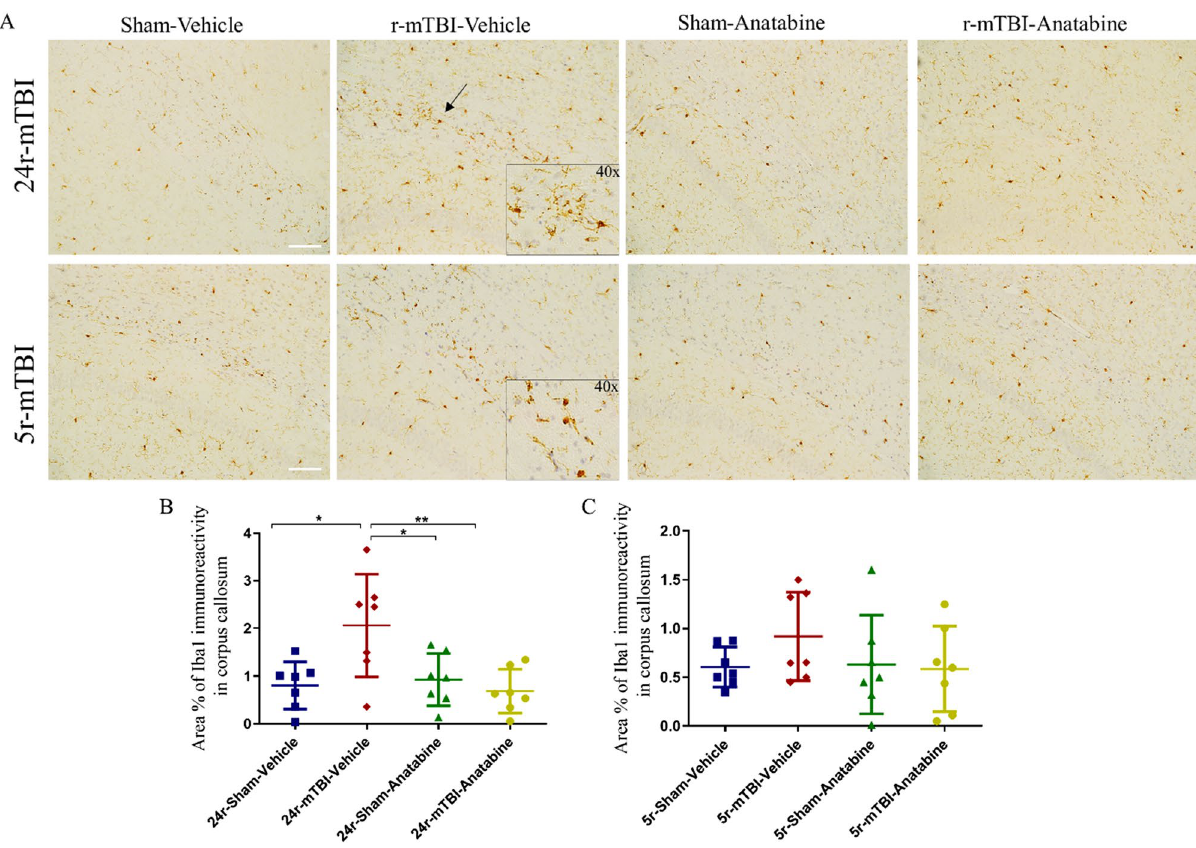
Figure 6. Evaluation of the effect of anatabine on microglia. ( A ) Representative images of Iba1 in corpus callosum in the 5r-mTBI and 24r-mTBI mice. Arrow indicates immunoreactive microglia. ( B ) 24r-mTBI-vehicle mice had an increase in Iba1 signal compared to 24r-sham-vehicle (p < 0.05). ( C ) In 5r-mTBI-vehicle mice, no increased Iba1 was detected. Anatabine decreased Iba1 in 24r-mTBI mice (24r-mTBI-anatabine vs 24r-mTBI- vehicle p < 0.05) but not in 5r-mTBI. Inserts of 40× images of reactive microglia are included in pictures of each r-mTBI-vehicle group. Data analyzed using two-way ANOVA. Scale bars equal 20